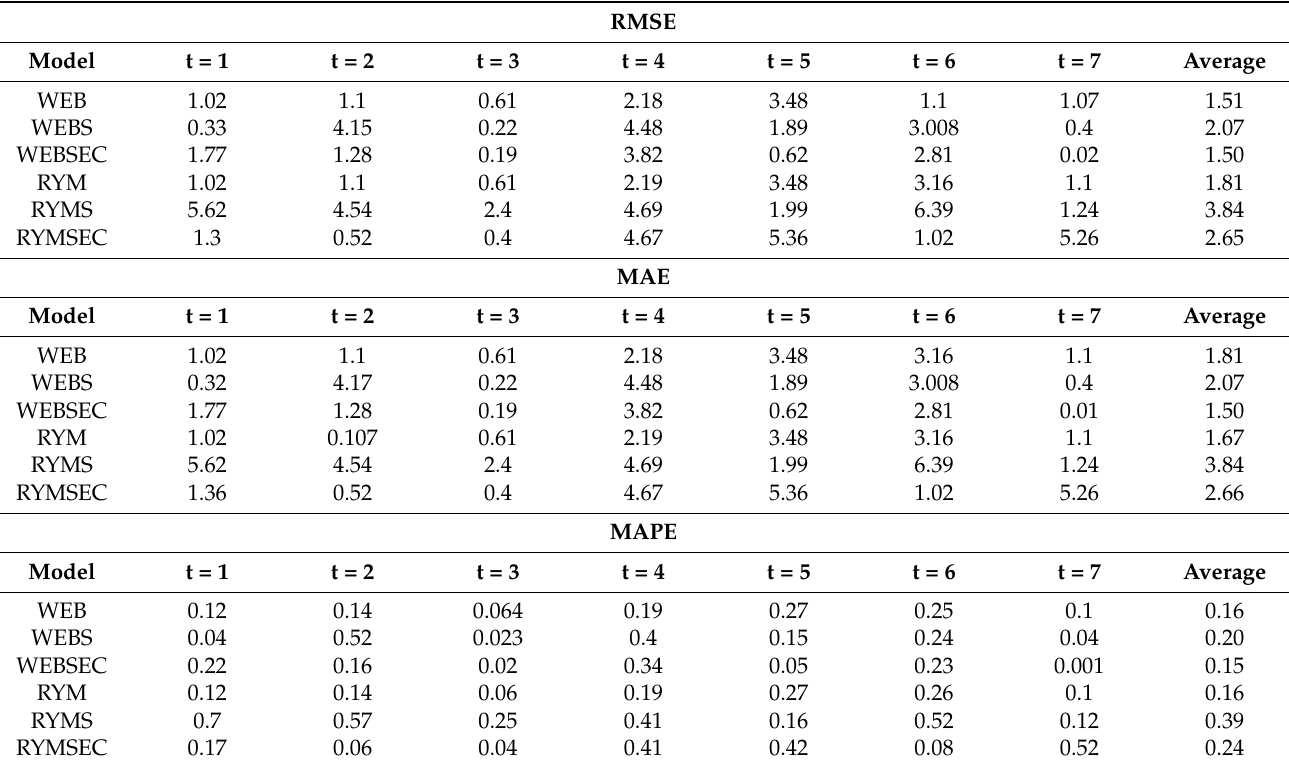
Table 2. Performance results of different WSP models for the South Plains TX region.